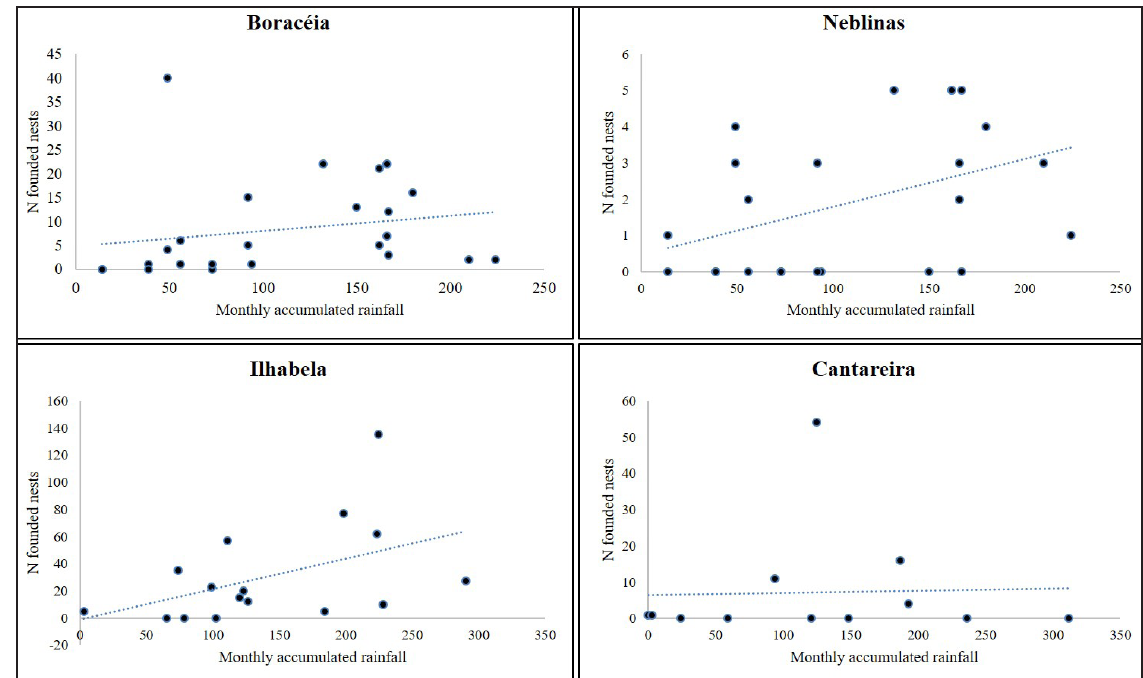
Fig 3 . Relationship between number of founded nests and monthly accumulated rainfall in four study areas.